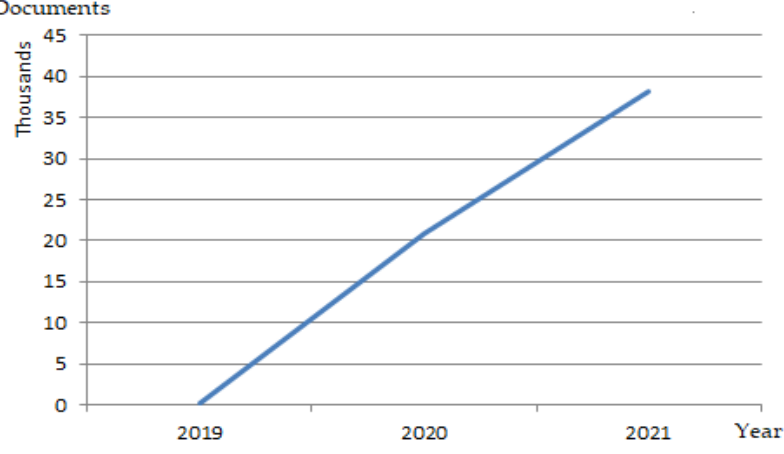
Figure 2. Human efforts to deal with the world (a subsystem: pandemic): ( a ). 1894–2000; ( b ). 2001–2019.